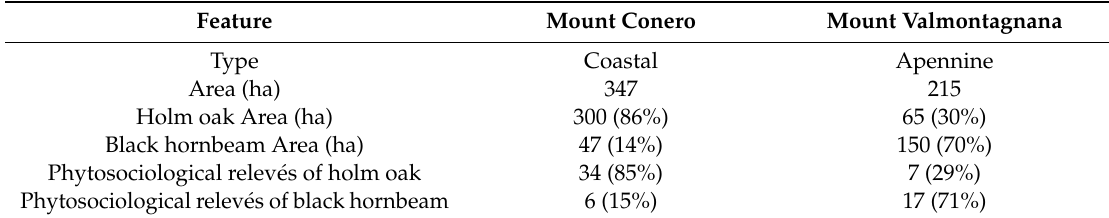
Table 1. Overview of main features related to adopted dataset. Values in round brackets show the distribution of phytosociological relev é s in that